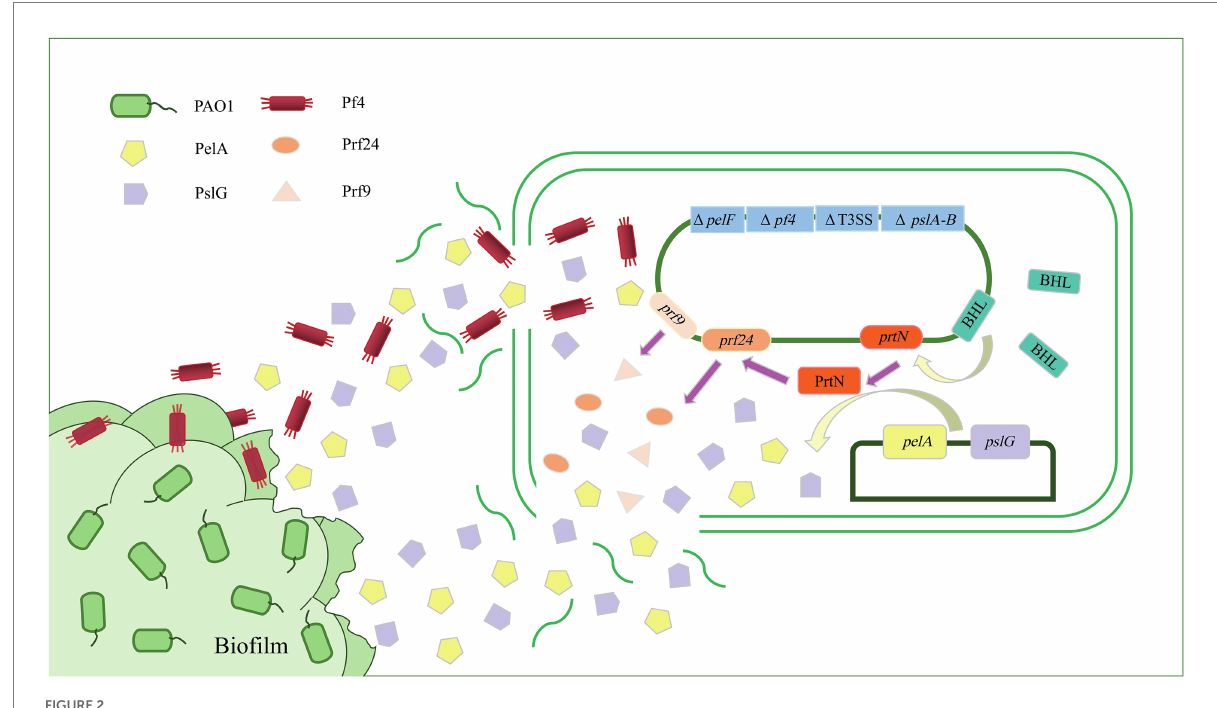
FIGURE 2 Schematic diagram of targeted delivery of extracellular glycoside hydrolase by engineered bacteria to destroy Pseudomonas aeruginosa biofilm. The biofilm formation and virulence-related genes pelA-B , pelF , and T3SS of P. aeruginosa were knocked out as parental strains, and exogenous recombinant vectors were introduced to overexpress the exopolysaccharide hydrolases PelA and PslG. PelA and PslG accumulated in cells and were then released into the extracellular matrix through cell lysis. There are two ways in which hydrolases are released into the extracellular matrix. The first is through regulating the prtN gene to activate the expression of cell lysis protein genes, thereby releasing PelA and PslG. The second is by deleting the Pf4 filamentous prophage-encoding gene cluster to sensitize it to the Pf4 phage in biofilms, thereby initiating the passive lysis mechanism of its own cells to release PelA and PslG. The PelA and PslG are released to the extracellular matrix to destroy the biofilm skeleton components Pel and Psl through enzymatic hydrolysis, thereby destroying the P. aeruginosa